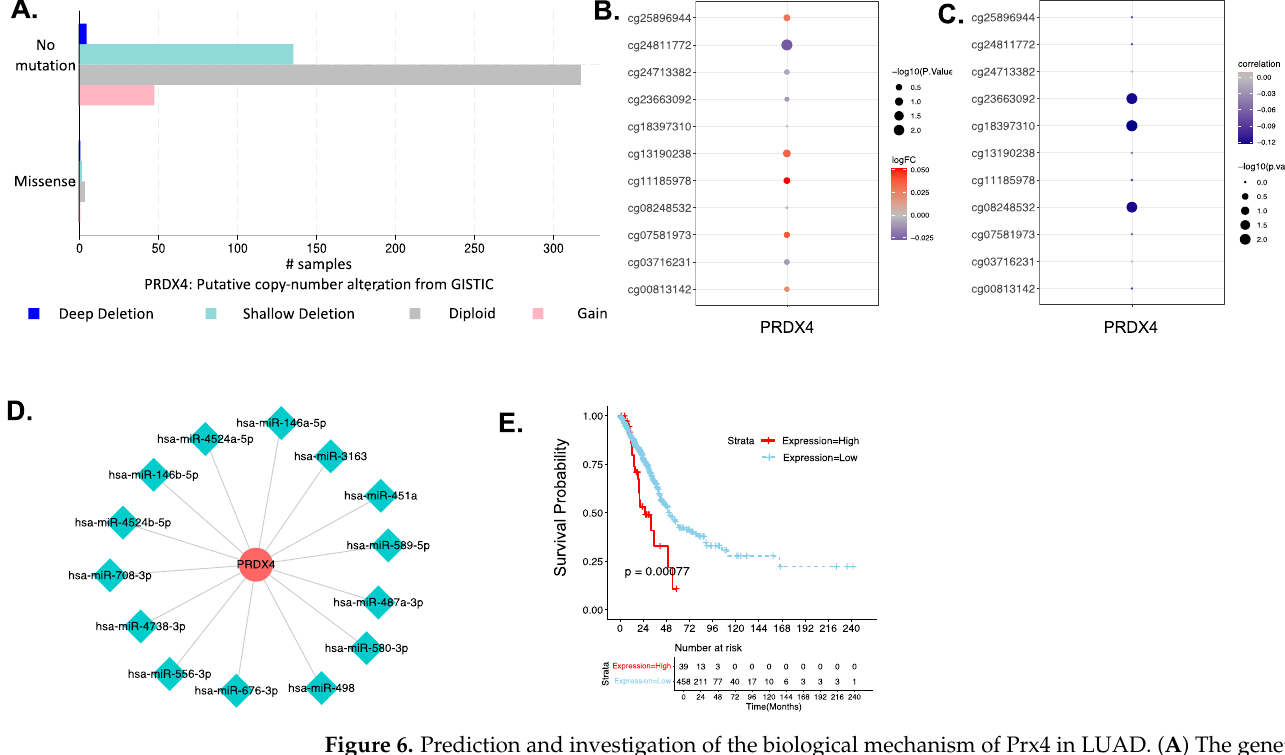
Figure 6. Prediction and investigation of the biological mechanism of Prx4 in LUAD. ( A ) The genetic alteration of PRDX4 in LUAD from cBioPortal. ( B ) Methylation differences between LUAD and normal tissues. ( C ) Spearman correlation coefficient of methylation and gene expression. ( D ) miRNA prediction from miRwalk and ENCORI database. ( E ) Impact of has-miR-3163 on overall survival of LUAD patients. Table 3. The 12 predicted miRNA from ENCORI database.